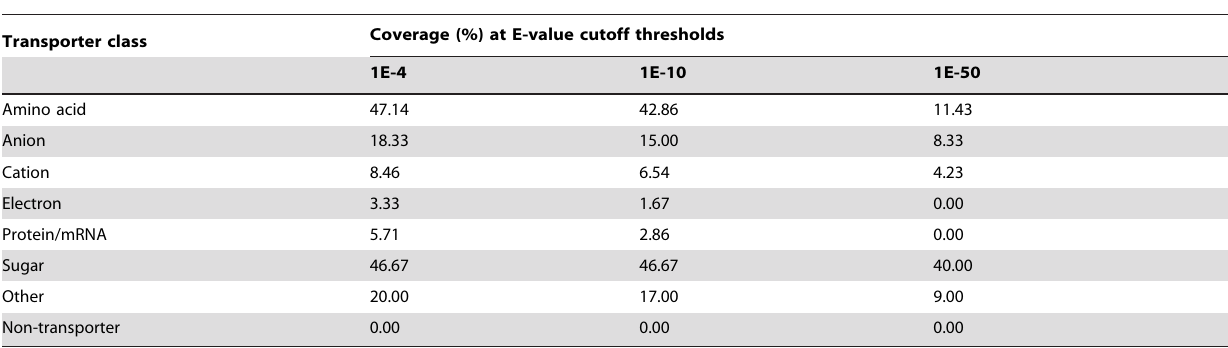
Table 10. The performance (coverage metric) of the HMM search on the main dataset using a five-fold cross-validation.